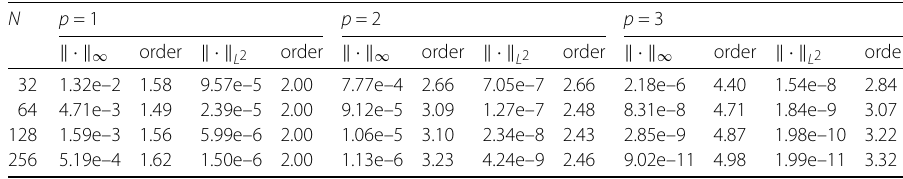
Figure 1 Convergence curve, Shishkin mesh, τ